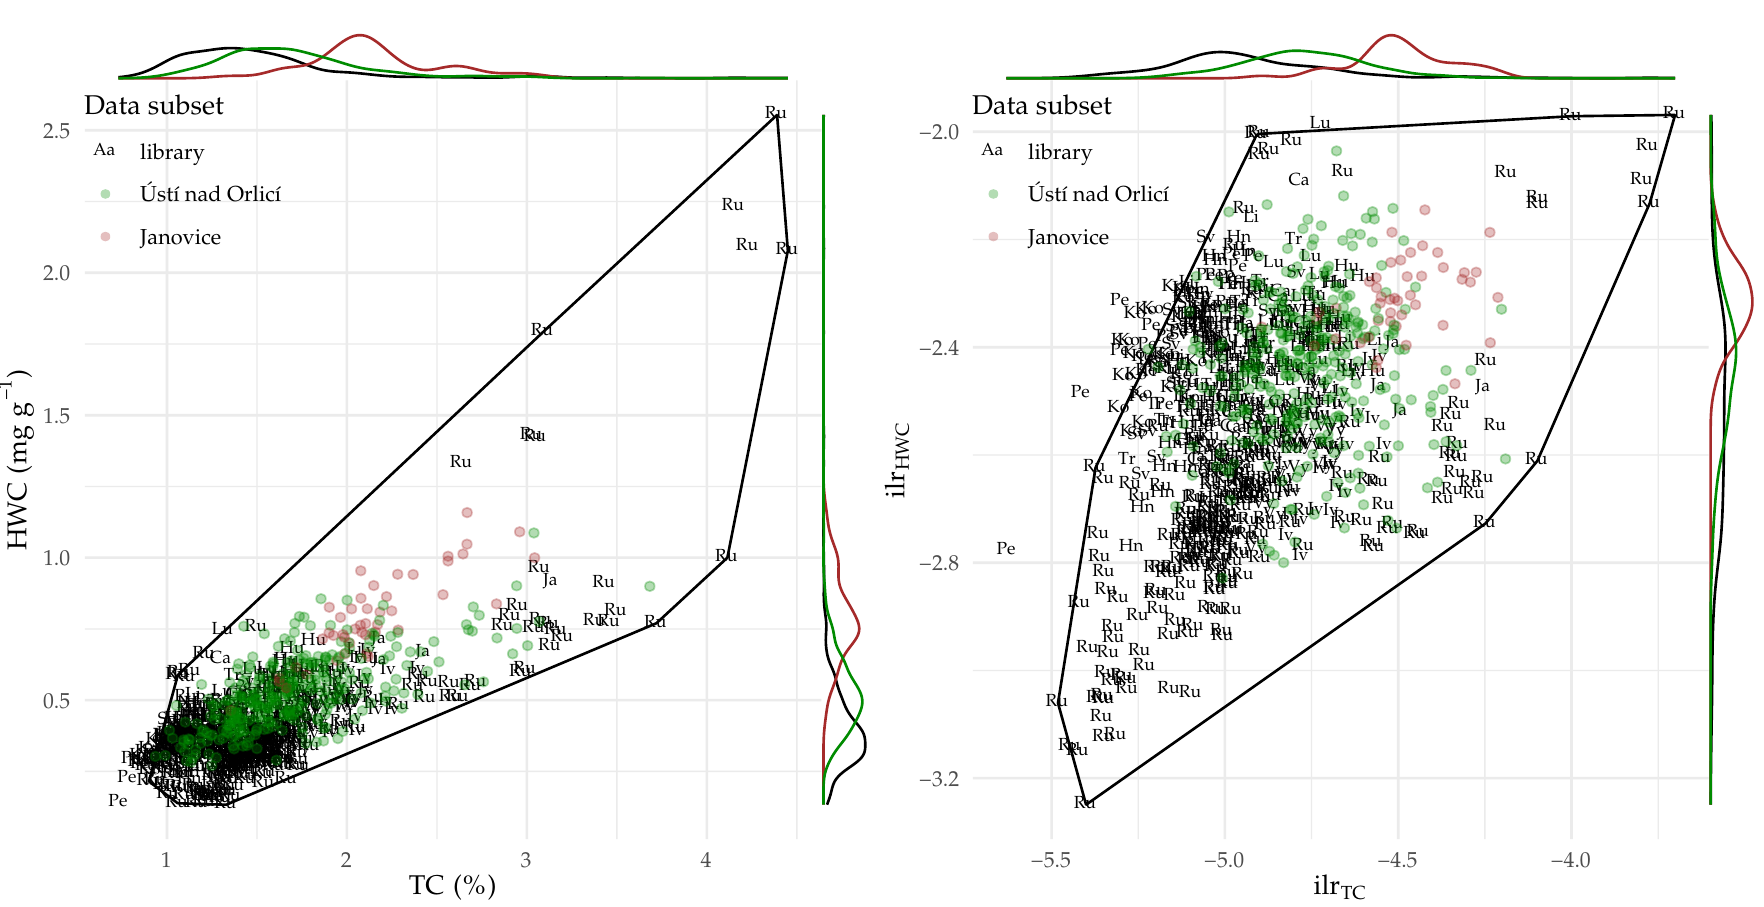
Figure 6. Joint and marginal distributions of SC raw and ilr-transformed measurements. The convex hull depicts the extent of Praha-Ruzynˇe observations. Ca—